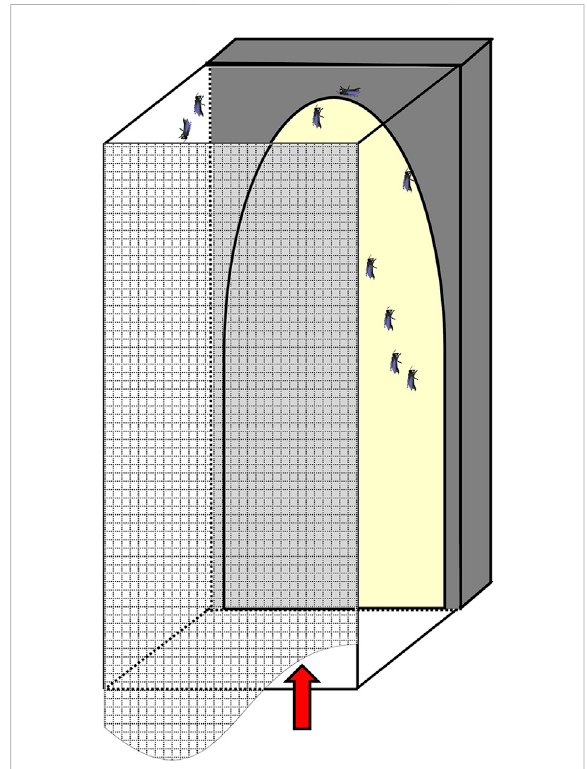
FIGURE 1 Glass box used for fl ight training. The box was covered with mosquito net (meshed) and light trap (yellow) on the back. Arrow indicates where bees are